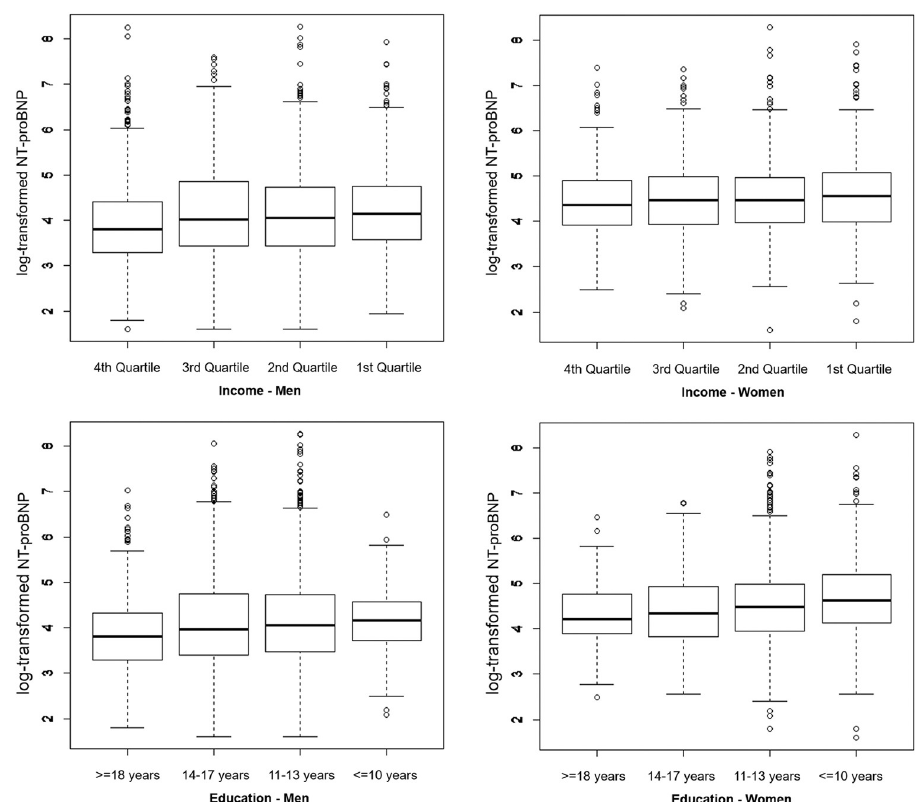
Fig 1. Boxplots illustrating the distribution of log-transformed NT-proBNP across income quartiles and education groups stratified by sex.